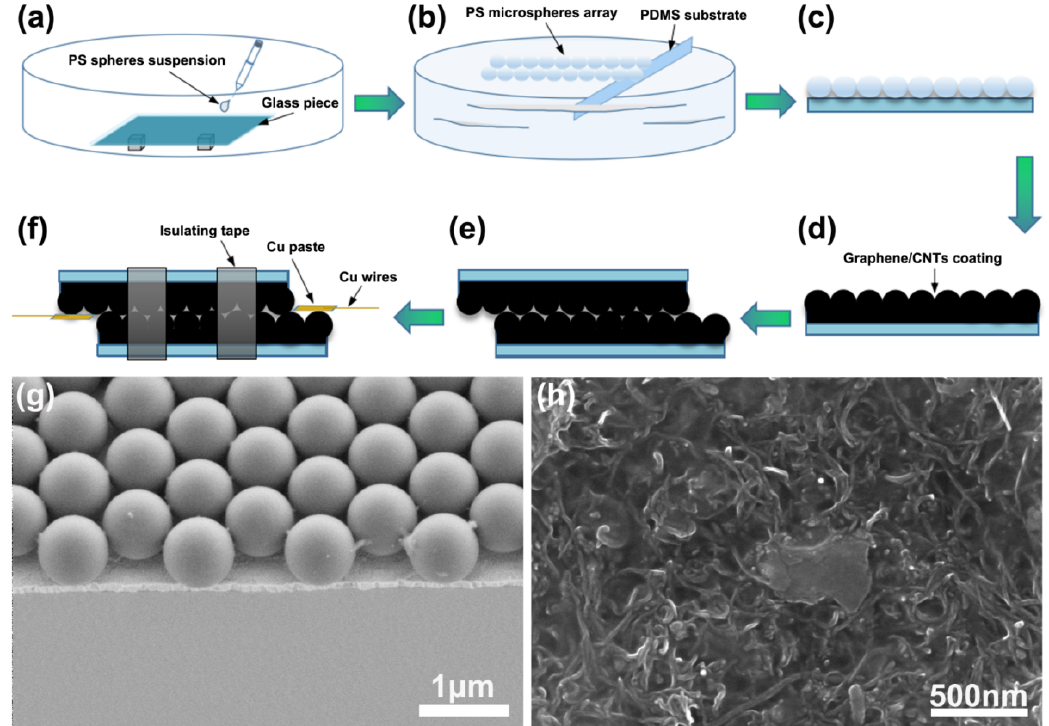
Figure 1. Sensor design and characterization. ( a ) Self-assembly of PS microspheres. ( b ) Assembling the microsphere on the PDMS substrate. ( c ) PDMS film coated with PS microsphere array. ( d ) Coating graphene/CNTs conductive solution on PS microsphere array. ( e ) Stack the two conductive sheets as shown in ( d ). ( f ) Flexible pressure sensor based on graphene/carbon nanotubes. ( g ) Scanning electron micrograph (SEM) of monolayer PS microsphere array. ( h ) SEM image of the surface of graphene/CNTs conductive coating.